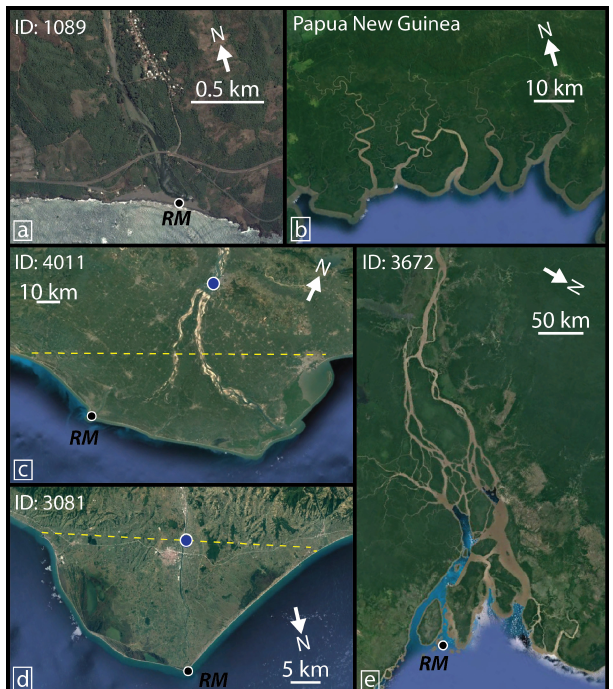
Figure 1. Examples of (a) a river mouth without a delta (Mexico), (b) headless tidal channels not included in this dataset, (c) a delta with land both upstream and downstream of the regional shoreline vector (marked by dashed line – location of delta node demarcated with blue dot; Godavari River, India), (d) a delta distinguished by a shoreline protrusion only (Red River, Turkey), and (e) a delta distin- guished by a distributary channel network only. RM locations mark the main river channel mouth (Amazon River, South America). Map data: ©Google and